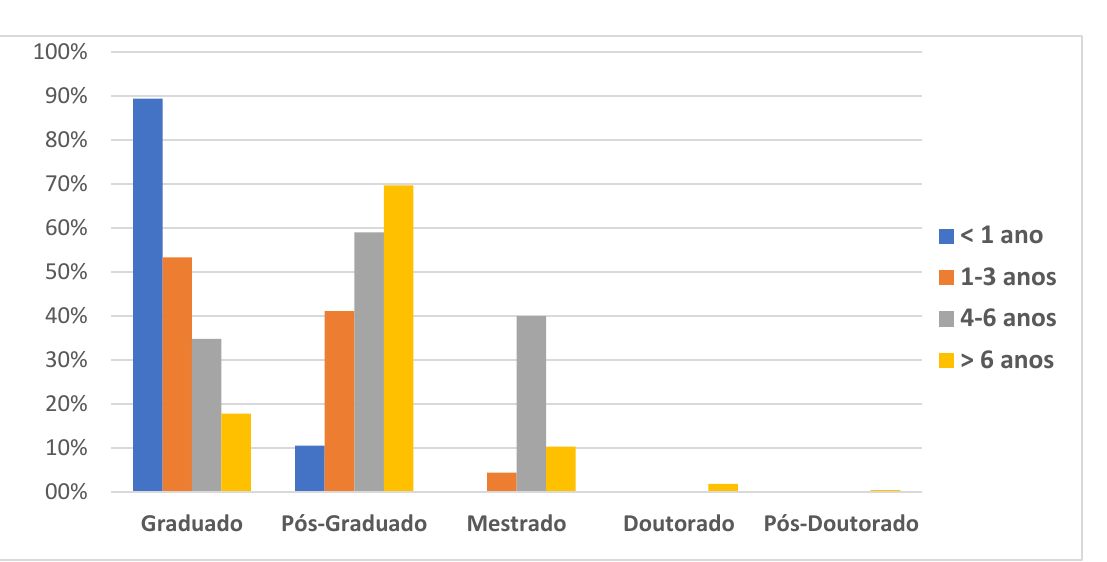
Figure 1. Representation of the participants’ academic background.